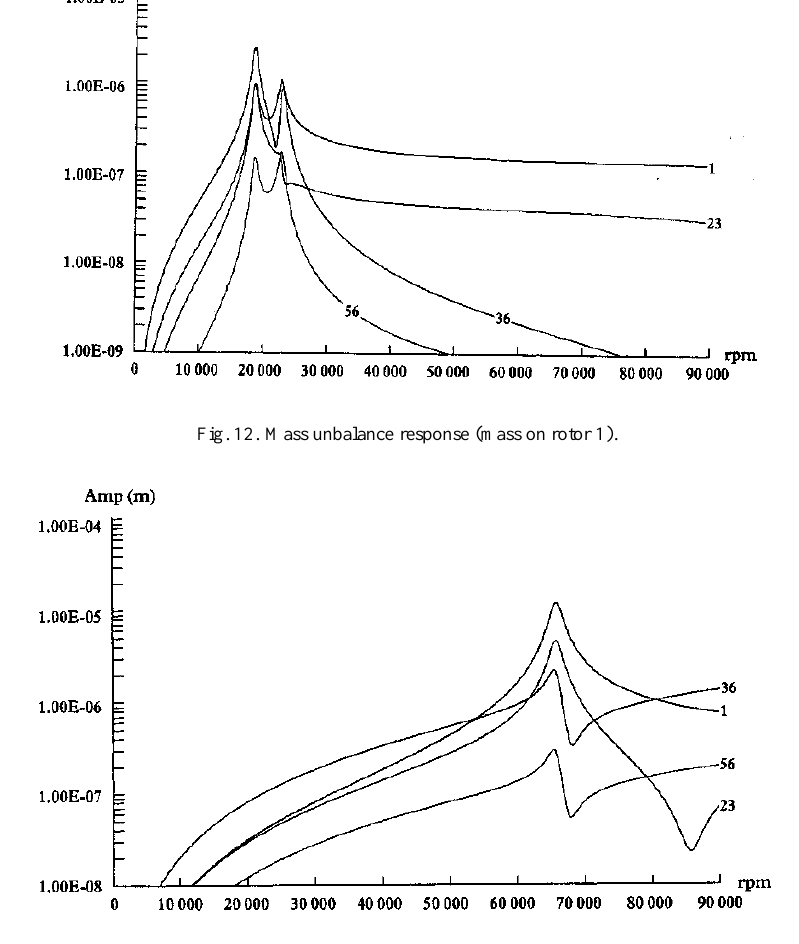
Fig. 13. Mass unbalance response (mass on rotor